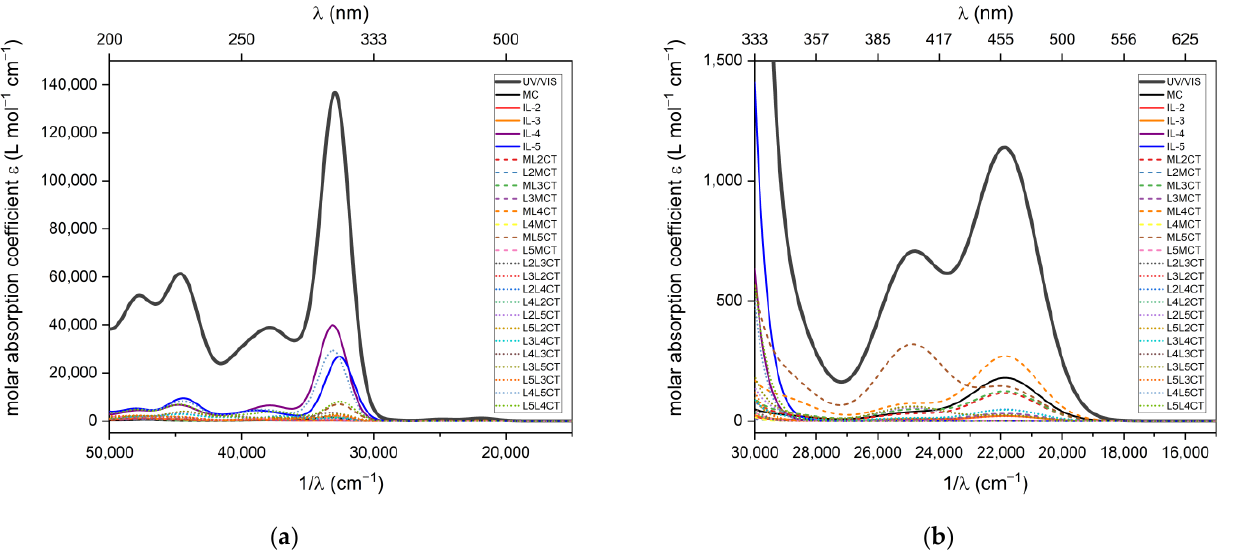
Figure 8. The TD-DFT calculated absorption spectrum of L in the UV ( a ) and visible part ( b ) with the individual fragment contributions as deduced from IFCT analysis. The metal-centered states (MC), intra-ligand states (IL), metal-to-ligand charge transfer states (MLCT), ligand to-metal charge transfer states (LMCT), and ligand-to-ligand charge transfer states (LLCT) are numbered according to the molecular fragments showed in Figure 7. The spectrum was calculated by setting value of 2500 cm −1 for full width at half maximum (FWHM).